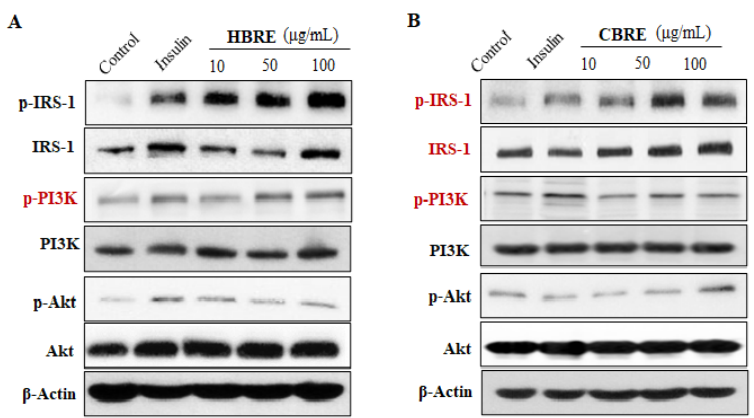
Figure 3. Effect of black rice extracts on GLUT4 protein expression in plasma membrane of C2C12 myotubes. Cells were treated with indicated concentrations of ( A , B ) HBRE and ( C , D ) CBRE for 24 h, and the representative immunoblot and quantification graphs were presented (means ± SD). * p < 0.05 vs. control group.